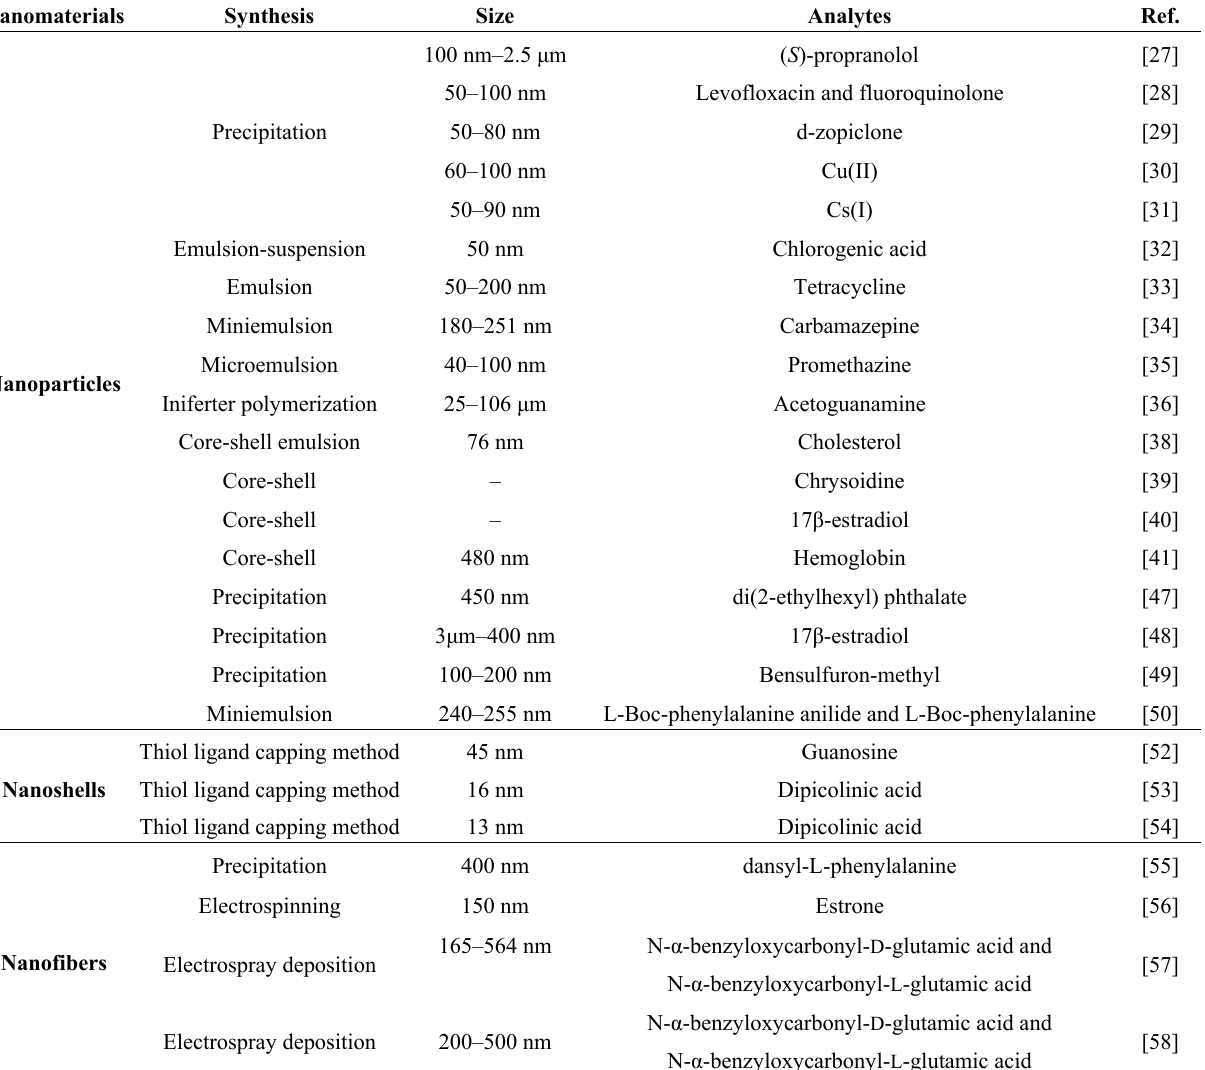
Table 1. Selected examples of different types of molecularly imprinted nanomaterials synthesized by various approaches, their particle size and for intended targets are summarized